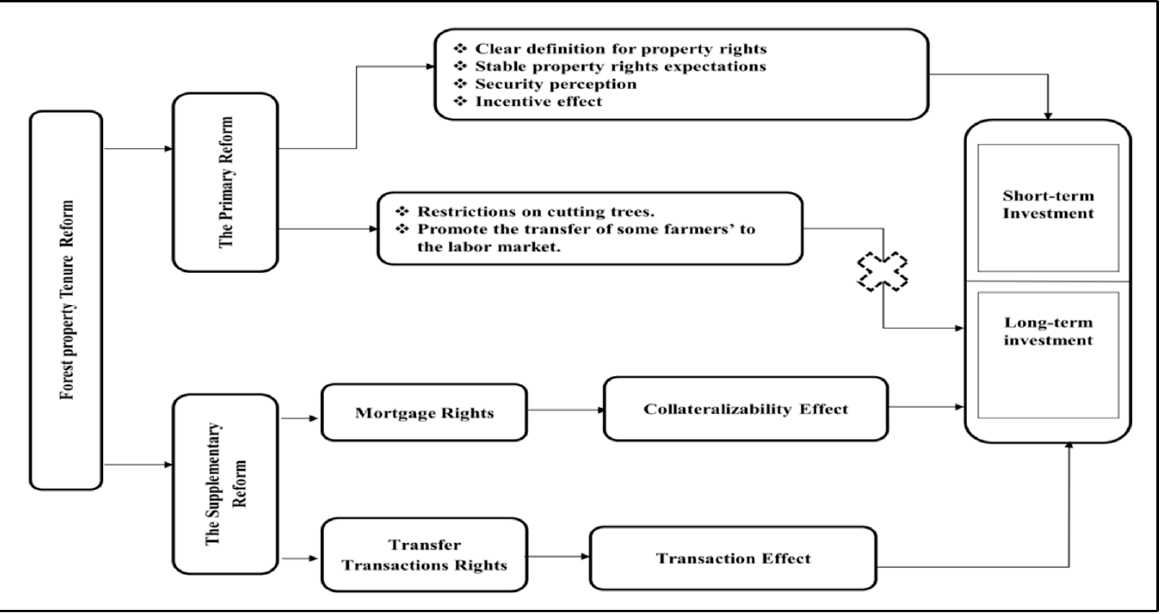
Figure 1. Effect mechanism of forest tenure reform on farmer’s investment in the public welfare forest area.